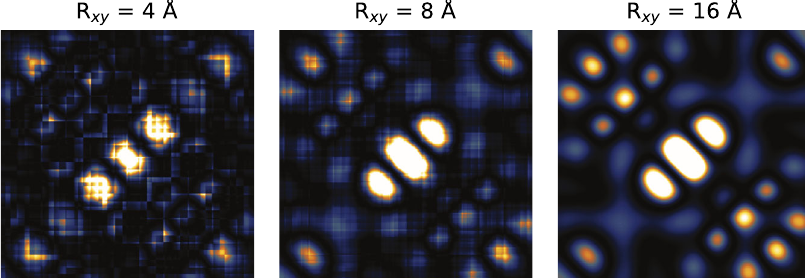
Fig. 8 Effect of lateral cut-off distance on STM images. Panels represent a series of simulated STM images for increasing values of lateral cut- off distance. In each image, every pixel is simulated by adding the contributions from all atoms ± R xy from the image point in both x and y lateral dimension and up to depth R z = 20 Å , resulting in the total volume for each pixel equal to ð 2 R xy Þ 2 ´ R z .